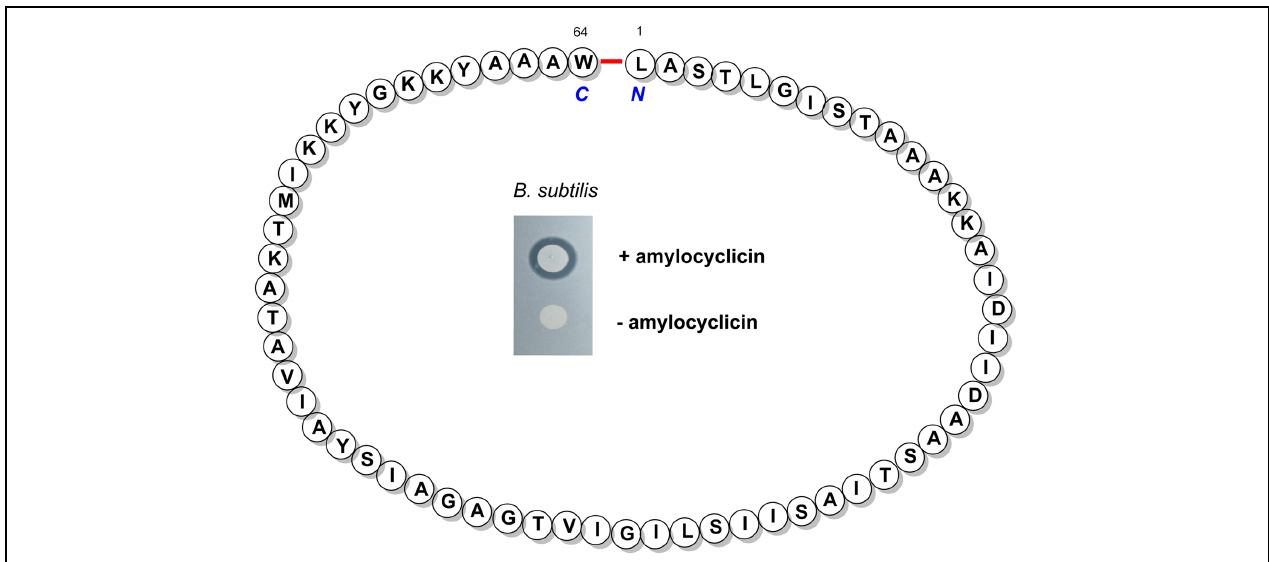
FIGURE 3 | The structure of the mature bacteriocin amylocyclicin bearing a head-to-tail cyclization of L 1 and W 64 . Inset: Amylocyclicin effect on a related B. subtilis strain without immunity against the bacteriocin was demonstrated by a spot-on-lawn test performed with a amylocyclicin producing (Top) and non-producing FZB42 strain (Bottom)